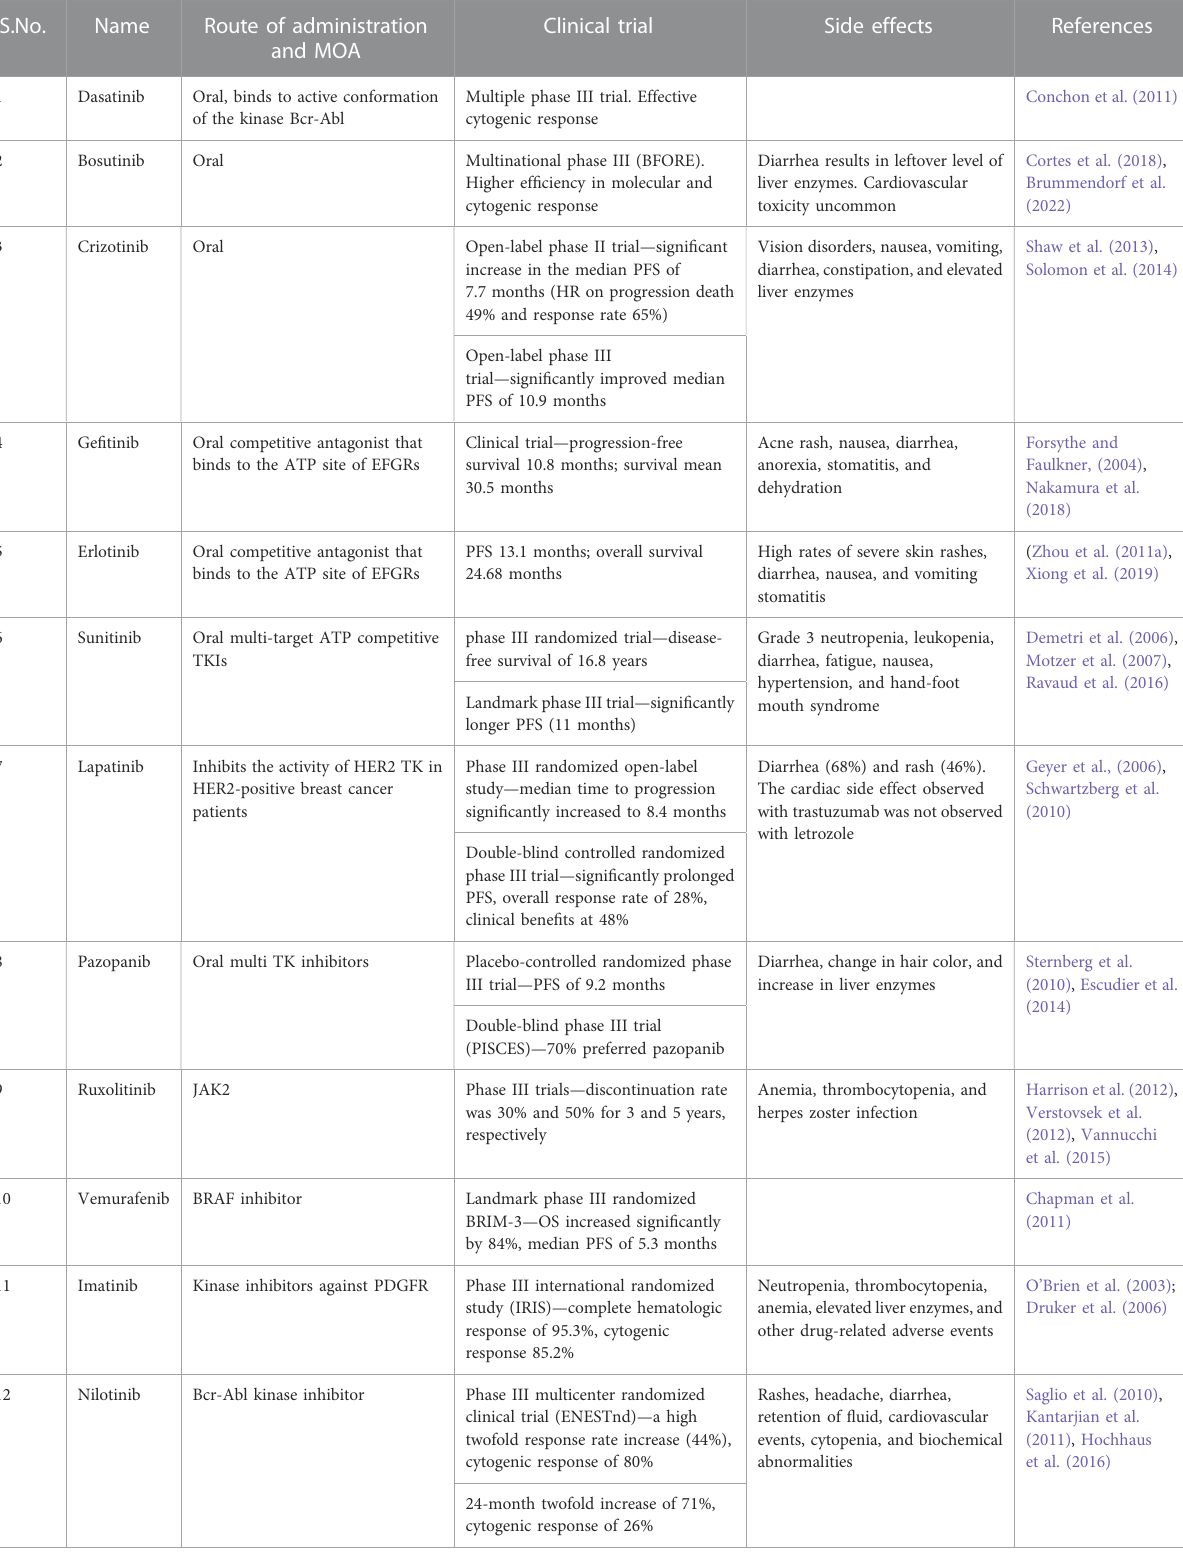
TABLE 3 Mechanism of action, results of clinical trials, and side effects of kinase inhibitors.